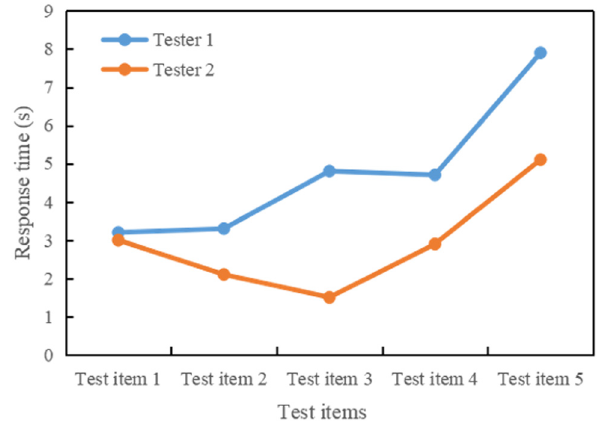
Figure 7: Test chart of system